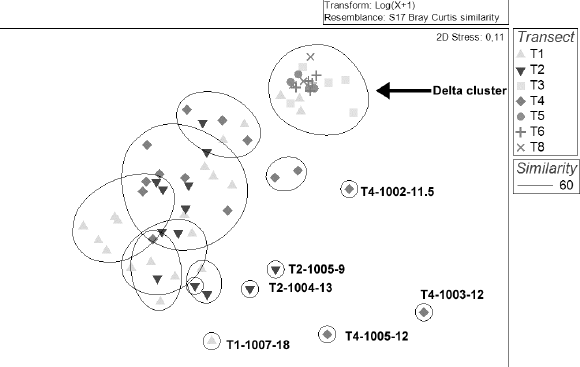
Figure 11 Fig. 11. Sample-environment biplot of the redundancy analysis car- ried out on all counted samples. For the calculation of the influence environmental factors, only those samples also used for the analysis of biological trends were included; site numbers: 1–22 = T1, 23–35 = T2, 36–40 = T3, 41–55 = T4, 56–59 = T5, 60–64 = T6, 65–67 =